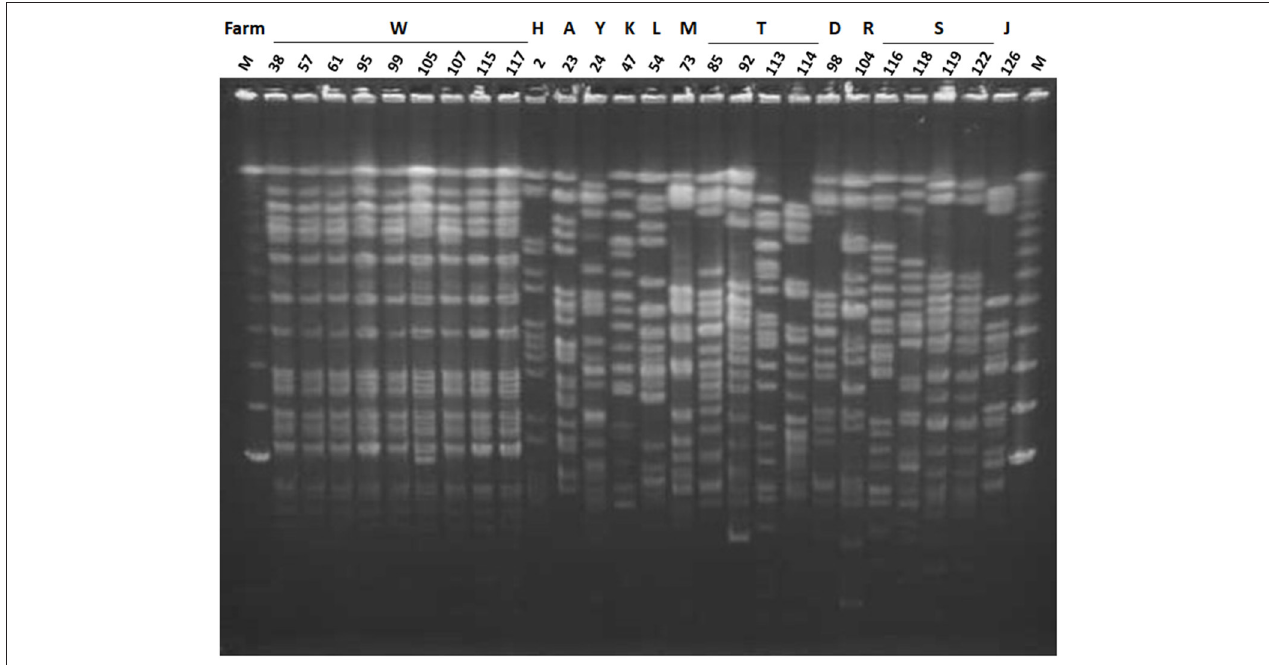
FIGURE 2 | Pulsed-field gel electrophoresis (PFGE) patterns of Xba I-digested genomic DNA of ESBL-producing K. pneumoniae and ESBL-producing K. oxytoca. Lanes: 38, strain Ko38; 57, strain Ko57; 61, strain Ko61; 95, strain Ko95; 99, strain Ko99; 105, strain Ko105; 107, strain Ko107; 115, strain Ko115; 117, strain Ko117; 2, strain Kp2; 23, strain Kp23; 24, strain Kp24; 47, strain Kp47; 54, strain Kp54; 73, strain Kp73; 85, strain Kp85; 92, strain Kp92; 113, strain Kp113; 114, strain Kp114; 98, strain Kp98; 104, strain Kp104; 116, strain Kp116; 118, strain Kp118; 119, strain Kp119; 122, strain Kp122; 126, strain Kp126; M, lambda DNA. Letters above the lanes represent the name of farms from which the strain was